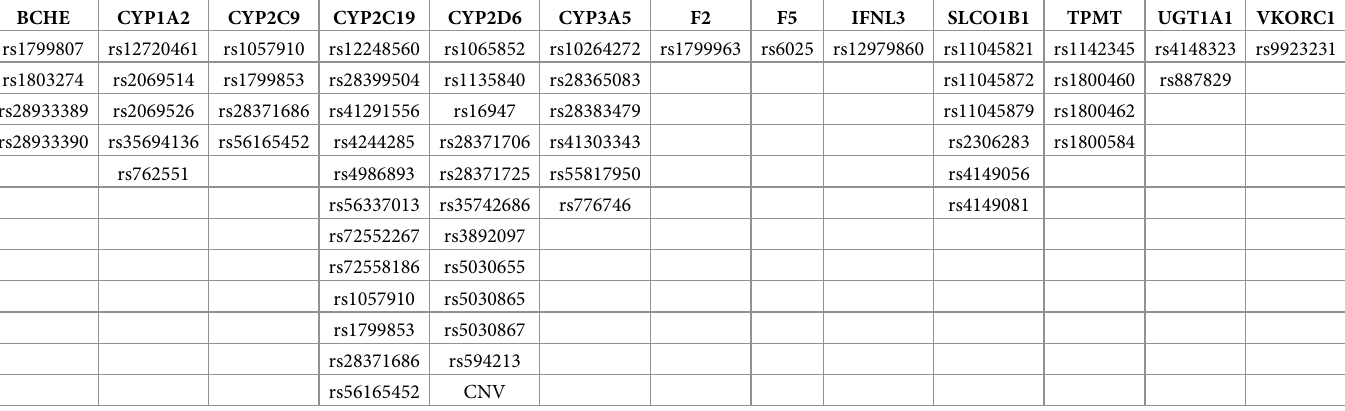
Table 2. List of 55 single nucleotide polymorphisms (SNPs) or other variants (indel or copy number variation (CNV)), detected in 13 drug metabolizing genes in the Kardiovize study population (n = 250 individuals). BCHE